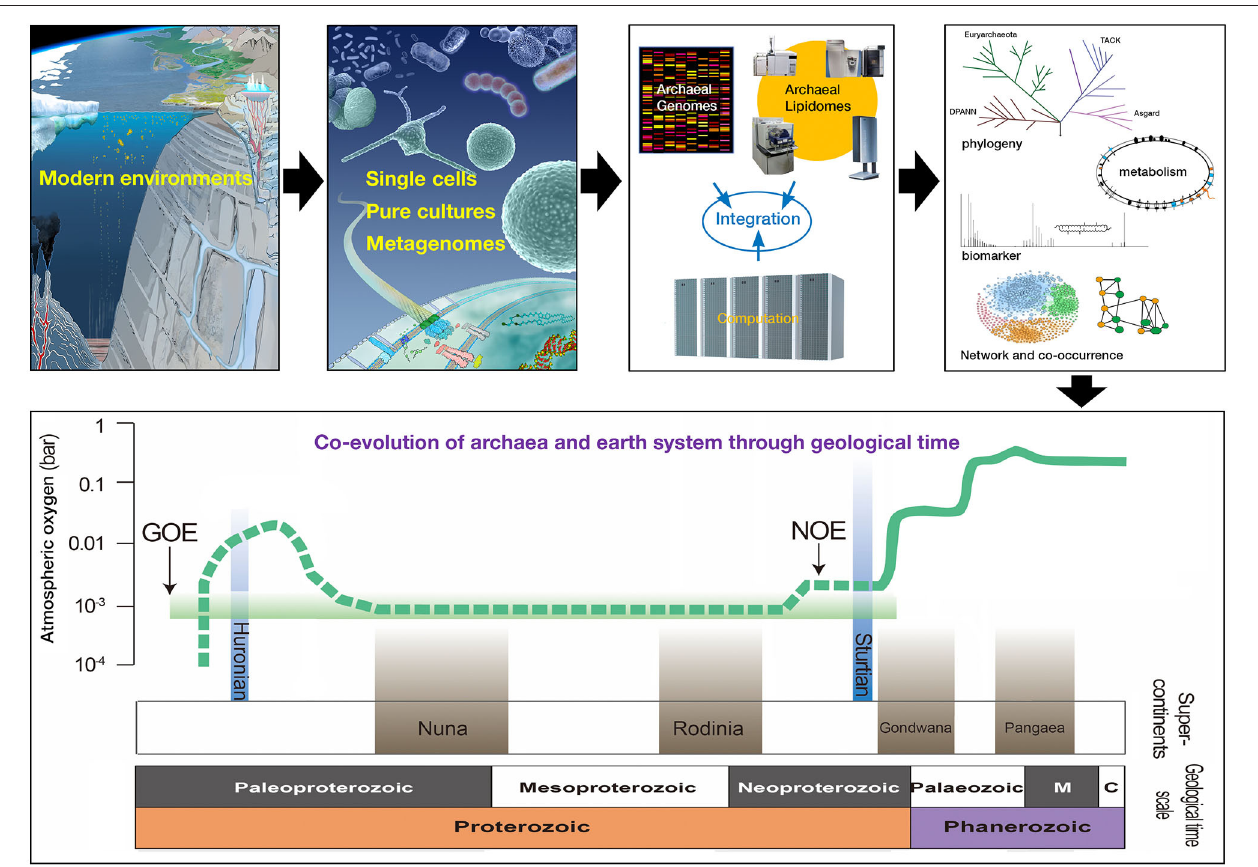
FIGURE 1 | Conceptual framework to study archaeal biology. Archaea can be studied in a variety of environments in part through cultivation, environmental genomics, and lipidomics. Diverse data streams can be integrated computationally and intellectually to address questions about archaeal metabolism, evolution, and ecology. Archaeal biomarkers can be retrieved from modern and ancient systems to reconstruct the co-evolution of archaea and earth system within a geological